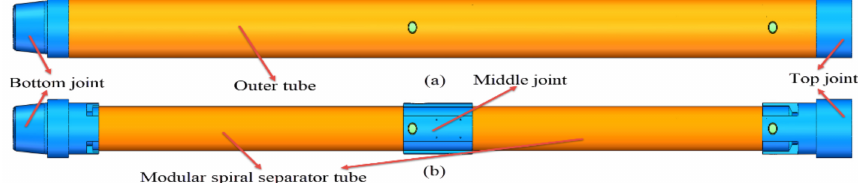
Figure 2. Schematic diagram of three-dimensional structure of the downhole spiral separator ( a ) is the external overall view, and ( b ) is the internal link diagram without external tube